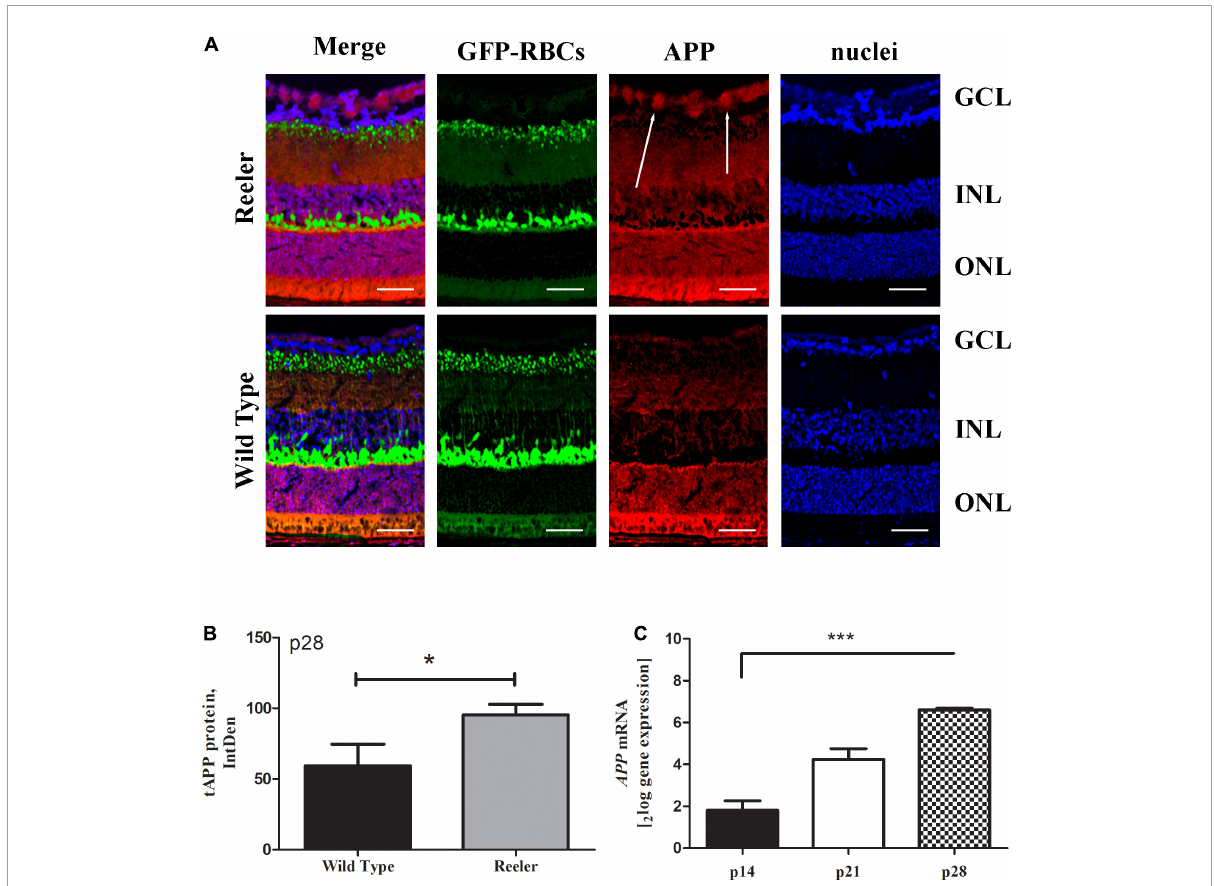
FIGURE1 Total APP immunoreactivity in Reeler retinas. (A) Representative confocal fluorescence microscopy images showing GFP-expressing RBCs (green), total APP immunoreactivity (red) and nuclear staining (dapi/blue). White arrows point to a noticeable staining of APP (red) at the GCL of Reeler retinas. (B) Histogram representative of APP IntDen analysis (mean ± SEM) in both Reeler and WT retinas. Note the increased values for APP in p28 Reeler with respect to WT ( n = 3 optic fields per slide of 3 animals per group; * p < 0.05, Kruskal Wallis analysis with post Dunn’s multiple comparison test analysis). (C) The mRNA expression levels of APP was assessed in not pooled retinas derived from Reeler and WT mice at p14, p21 and p28 days of age, normalized with GAPDH and shown as fold changes (*** p < 0.0001; REST analysis). APP,